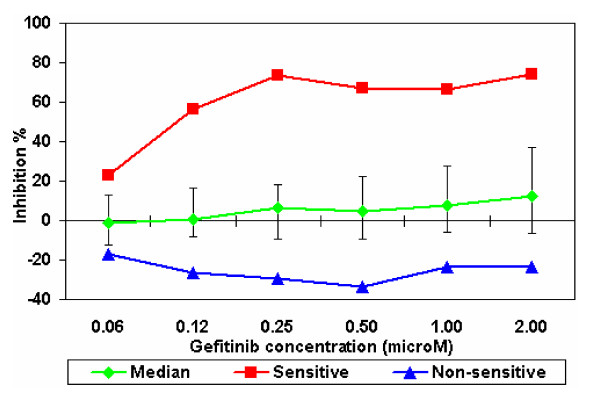
Median effect of gefitinib on tumour-derived cells compared with a sensitive and non-sensitive colorectal tumour. Error bars show 25th and 75th inter-quartile range.